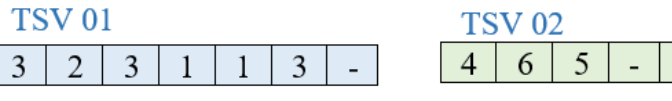
Figure 14. Time slot vectors for sub-nets. Algorithm 2: Data slot